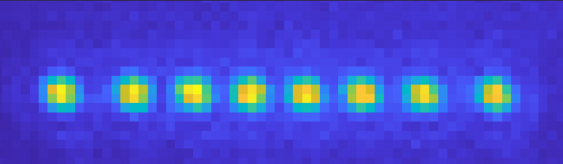
FIG. 4. An image of an eight-ion chain on the iXon Ultra cam- era. Here, the minimal interion distance is about 2.3 μ m. The ion chain is aligned along the pixel axis using a dove prism set before the camera.